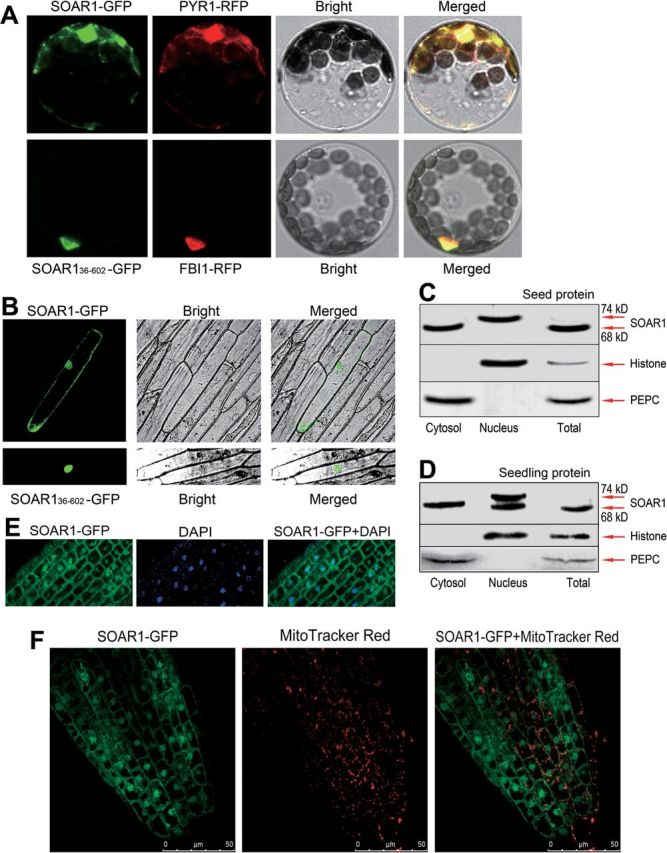
SOAR1 is localized in both the cytosol and nucleus. (A) Transient expression in Arabidopsis protoplasts. Top panels: SOAR1 is co-localized with a nuclear–cytosol-localized protein PYR1 (At4g17870; Park et al., 2009). SOAR1 was tagged with green fluorescent protein (SOAR1–GFP), and PYR1 protein was tagged with mCherry (PYR1–RFP). Bottom panels: the N-terminal truncated SOAR1 (SOAR136–602, with 35 amino acid residues deleted at the N-terminus of the SOAR1 protein; see Supplementary Fig. S1A at JXB online) is co-localized with a nuclear-localized FBI1 bHLH transcription factor (At1g02340; Fairchild et al., 2000; Jang et al., 2005). SOAR136–602 was tagged with GFP (SOAR136–602–GFP), and FBI1 protein was tagged with mCherry (FBI1–RFP). Bright, bright-field; Merged, merged image. The experiments were repeated five times with the same results. (B) Transient expression of the above-mentioned constructs in onion epidermis cells. (C) and (D) Immunoblot analysis of the SOAR1 protein in the total protein (Total), cytosolic (Cytosol), and nuclear (Nucleus) fractions from the seeds sampled 24h after stratification (C) and 10-day-old seedlings (D). Histone H3 (nuclear marker) and PEPC (phosphoenolpyruvate carboxylase; cytosolic marker) were tested in the cytosolic and nuclear fractions to estimate the purity of the fractions. (E) Transgenic expression of the SOAR1–GFP fusion protein in Arabidopsis whole plants. A portion of the SOAR1–GFP fusion protein (left) and a nuclear marker DAPI (middle) are co-localized to the nucleus (right, SOAR1–GFP+DAPI) in the root of the transgenic line OE1. The experiments were repeated five times with the same results. (F) Transgenic expression of the SOAR1–GFP fusion protein in Arabidopsis whole plants. Investigations were performed in the root of the OE1 line. SOAR1–GFP, the distribution pattern of SOAR1–GFP fusion protein (left); Mito Tracker Red, the profile of mitochondria stained by Mito Tracker Red (middle); SOAR1–GFP+Mito Tracker Red, merged image of SOAR1–GFP and Mito Tracker Red (right). The images show that SOAR1–GFP localization is distinct from the Mito Tracker Red-stained mitochondrial profile. The experiments were repeated five times with the same results.